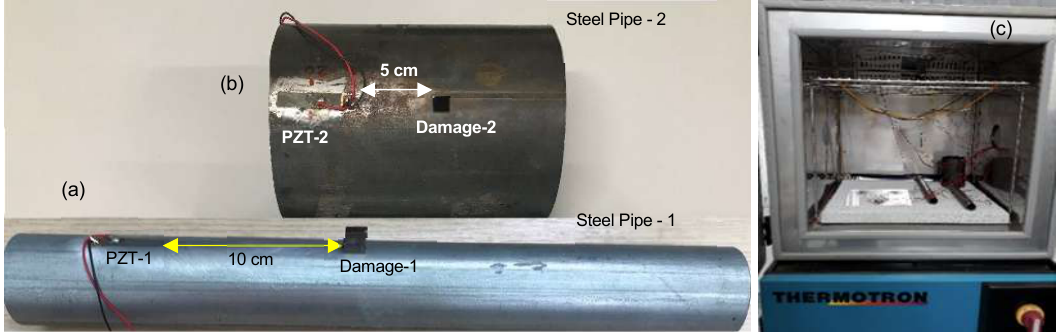
Figure 2. Steel- pipe/PZT real systems: ( a ) pipe-1; ( b ) pipe-2; and ( c ) Environmental chamber. Table 1. Types of materials and dimensions of the structures, PZTs, and damage.